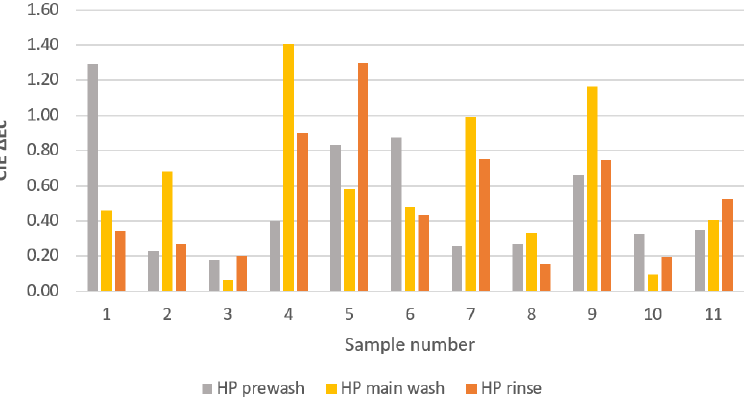
Figure 6. Colour difference, Δ E c* , of textile samples determined as the difference of CIE L * a * b * values of the samples after five consecutive washings without and with the addition of 3% HP in the pre- wash, main wash and rinse cycles